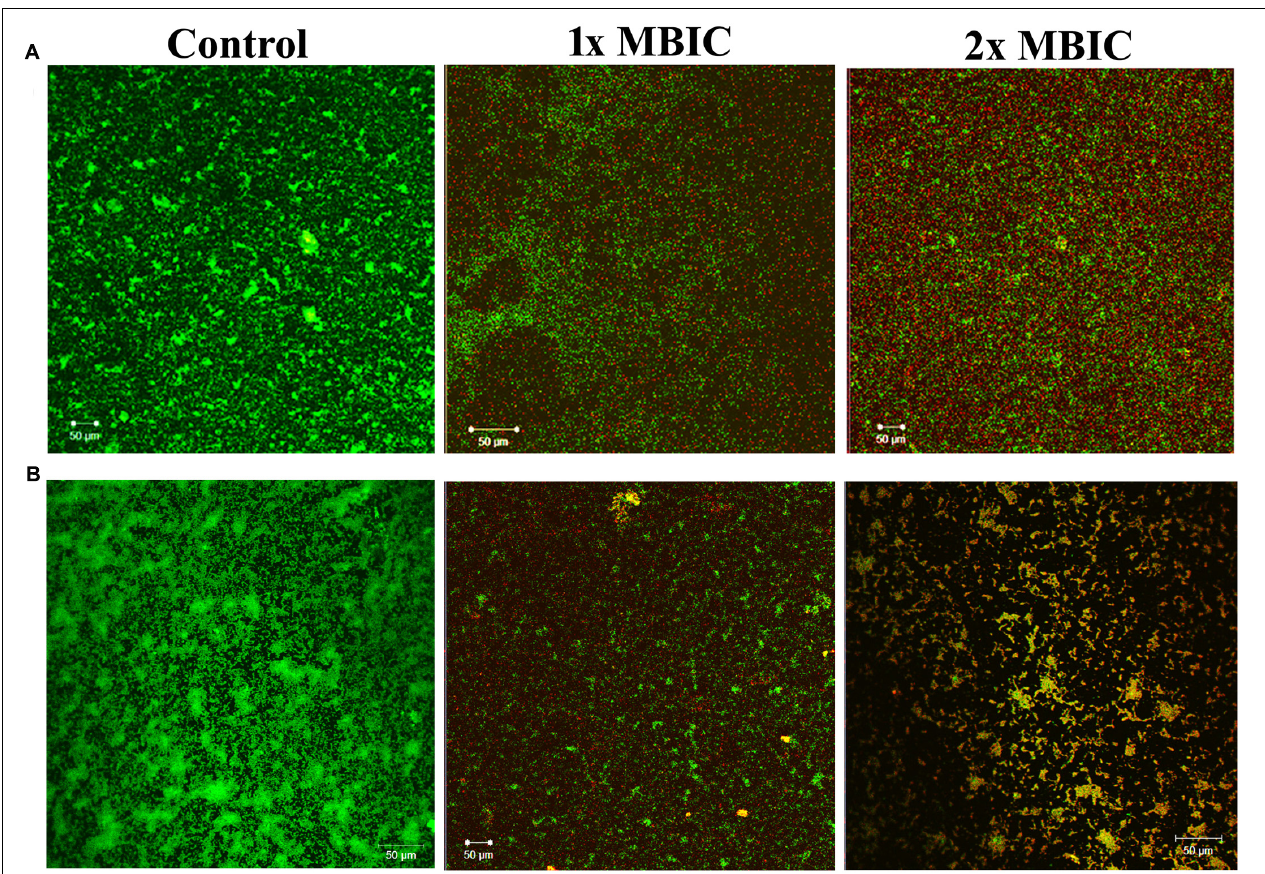
FIGURE 7 | Confocal laser scanning microscopic analysis of the effect of HMB (at 1 × MBIC and 2 × MBIC) on preformed biofilm (24 h old) of Proteus mirabilis (A) ATCC and (B) CI using live/dead BacLight bacterial viability staining. Green fluorescence (SYTO9) represents viable cells and red fluorescence (PI) represents dead cells. CLSM, confocal laser scanning microscopy; HMB, 2-hydroxy-4-methoxybenzaldehyde; MBIC, minimum biofilm inhibitory concentration; ATCC, American Type Culture Collection; CI, clinical isolate; PI, propidium